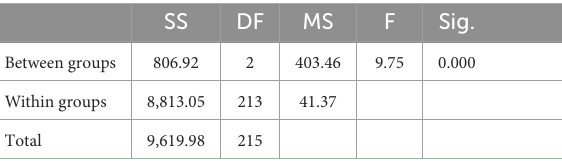
TABLE 4 One-way ANOVA results based on three anxiety types.